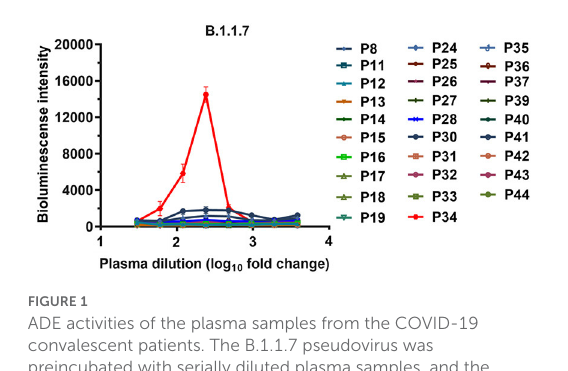
FIGURE1 ADE activities of the plasma samples from the COVID-19 convalescent patients. The B.1.1.7 pseudovirus was preincubated with serially diluted plasma samples, and the mixtures were added to Daudi cells to evaluate their ability to enhance infection. Each curve represents an individual plasma sample. RLU values resulting from infection with variant pseudotyped viruses were quantified by a luminescence meter. Data for each plasma sample were obtained from a representative infectivity experiment of three replicates and presented as the mean values ±